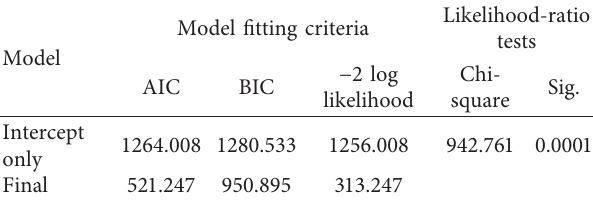
Table 4: Model fitting